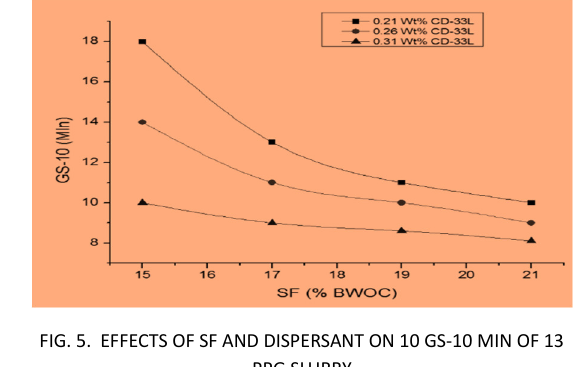
FIG. 5. EFFECTS OF SF AND DISPERSANT ON 10 GS-10 MIN OF 13 PPG